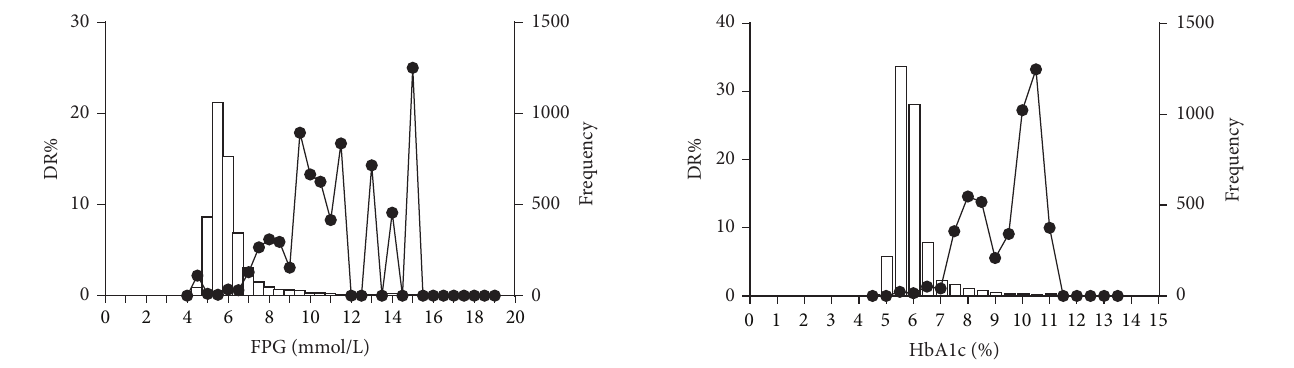
Figure 2: Distribution of glycated hemoglobin A1c (HbA1c) and the corresponding prevalence of diabetic retinopathy (DR) in the study